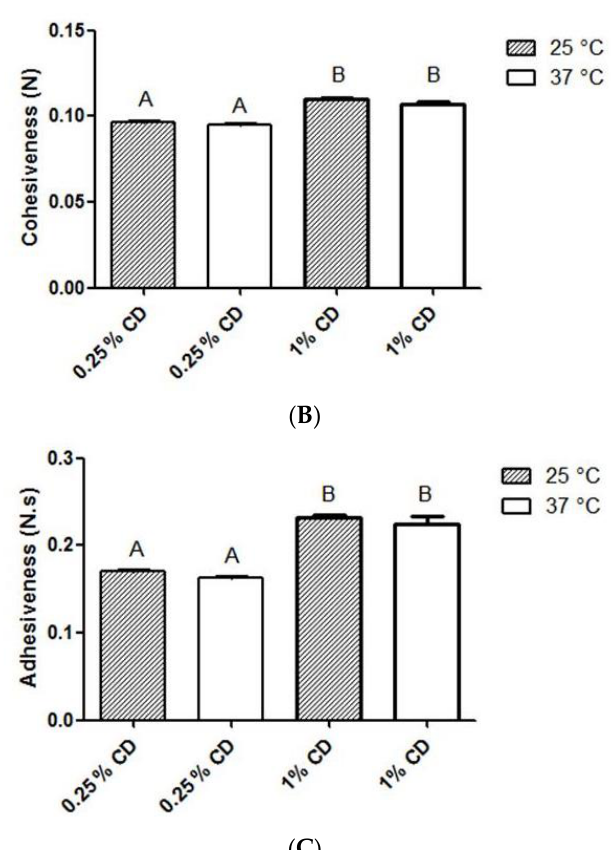
Figure 1. Consistency (panel A ), cohesiveness (panel B ), and adhesiveness (panel C ) of 0.25% and 1% chitosan dispersions at 25 °C and 37 °C. 0.25% CD: 0.25% chitosan dispersion; 1% CD: 1% chitosan dispersion. Data are expressed as mean ± standard deviation (n = 4). Columns sharing the same letter (A, B) are not significantly different from each other. ANOVA, Tukey post-hoc test, p < 0.05.